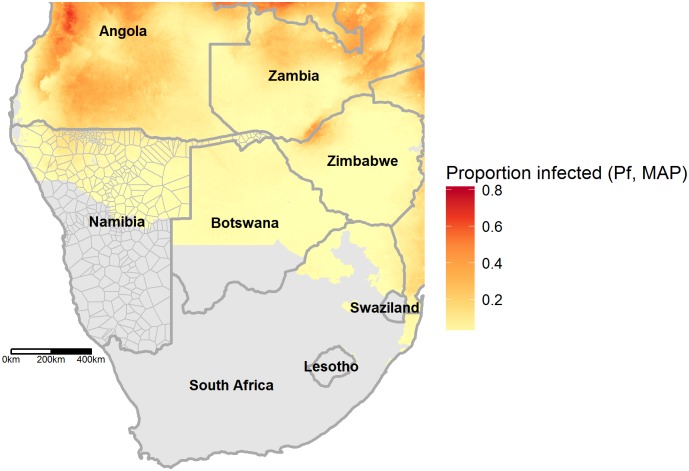
Regional map with parasite rate estimates from [10].Plasmodium falciparum parasite rate (PfPR) shown in yellow and red; grey areas indicate areas with no malaria or areas where predicted annual incidence is less than 1 per thousand people (PfPR surface adapted from [10]). National borders obtained from thematicmapping.org, and are available for use under a Creative Commons BY-SA license.